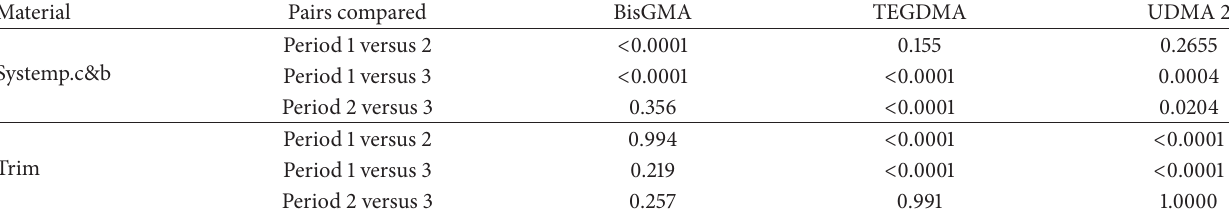
Table 4: Tukey’s test (adjusted 𝑃 values).